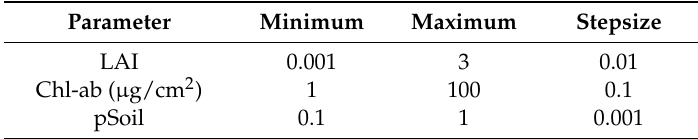
Table 3. Model inversion look up table properties. LAI: leaf area index; Chl-ab: Chlorophyll a+b content; pSoil: dry/wet soil fraction (=1-soil moisture